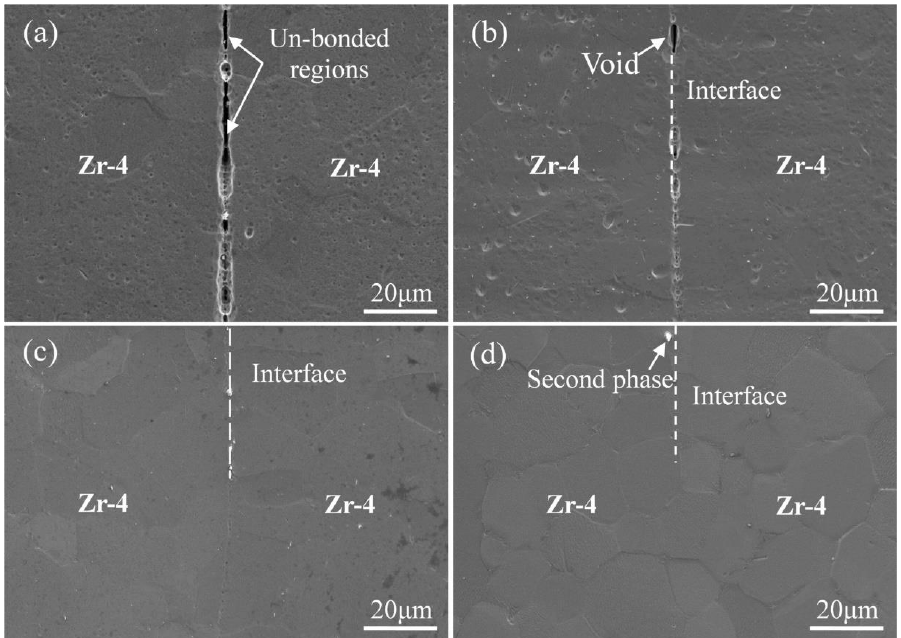
Figure 3. SEM images of the microstructure of the joint diffusion bonded at different temperatures (7 MPa/60 min): ( a ) 760 °C, ( b ) 780 °C, ( c ) 800 °C, and ( d ) 820 °C.